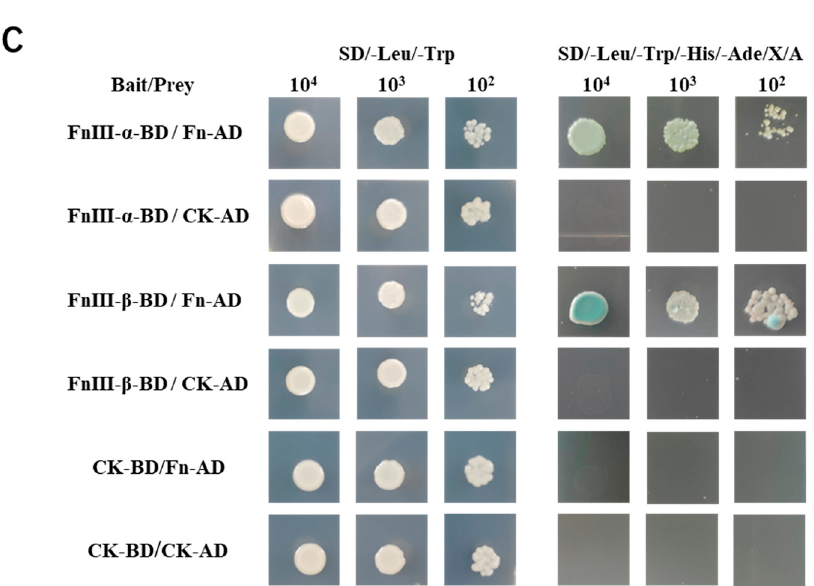
Figure 6. Interaction between Sb IGF-1R and Sb Fn. ( A ) Recombinant proteins of Sb Fn and Sb IGF-1R-FNIII and the specificity of their polyclonal antibodies. Line 1: Protein marker. Lines 2 and 3: Purified recombinant proteins of Sb Fn and Sb IGF-1R-FNIII, respectively. In lines 4 and 5, a Western blot analysis was performed using Sb Fn and Sb IGF-1R-FNIII polyclonal antibodies against the corresponding purified proteins. ( B ) Sb Fn colocalized with Sb IGF-1R in ark clam hemocytes. Extracellular Sb Fns were co-localized with Sb IGF-1Rs on the surface of the hemocytes. The positive Sb IGF-1R and Sb Fn signals are indicated in green and red, respectively. The nucleus is indicated by the blue signal of DAPI (scale bar = 10 μ m). ( C ) Yeast two-hybrid pairwise analysis showing the interaction of Sb IGF-1R and Sb Fn. FnIII-( α / β )-BD/Fn-AD are the experimental groups; CK-BD/CK-AD is the negative control; FnIII-( α / β )-BD/CK-AD and CK-BD/Fn-AD are the self-activation testing groups.